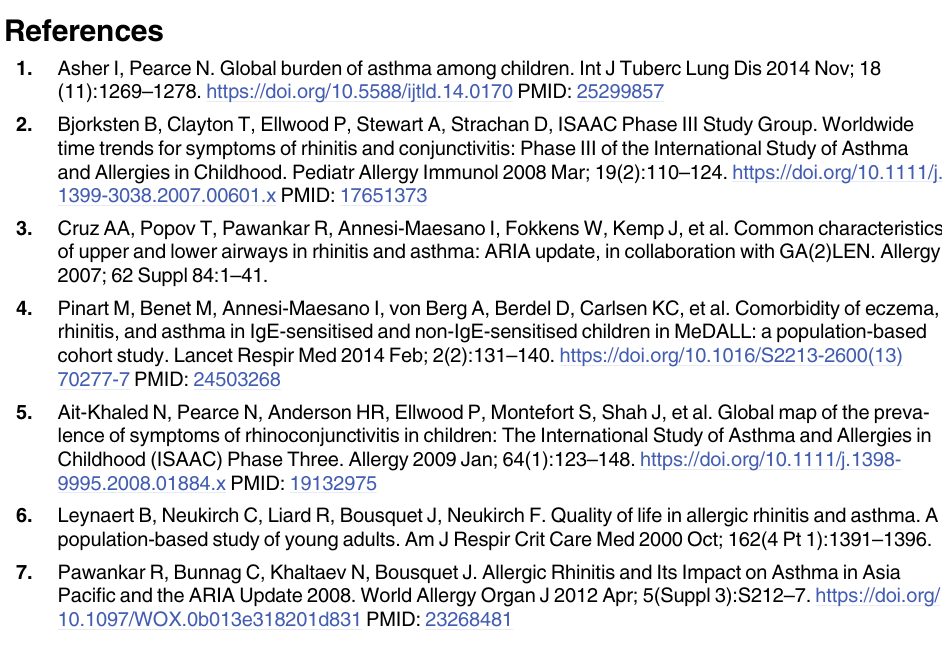
S1 Table. Unadjusted and adjusted 1 single and multipollutant logistic regression analyses evaluating the association of PM and black carbon with rhinoconjunctivitis quality of 2.5 life in young children and adolescents residing in Pampas and Villa,